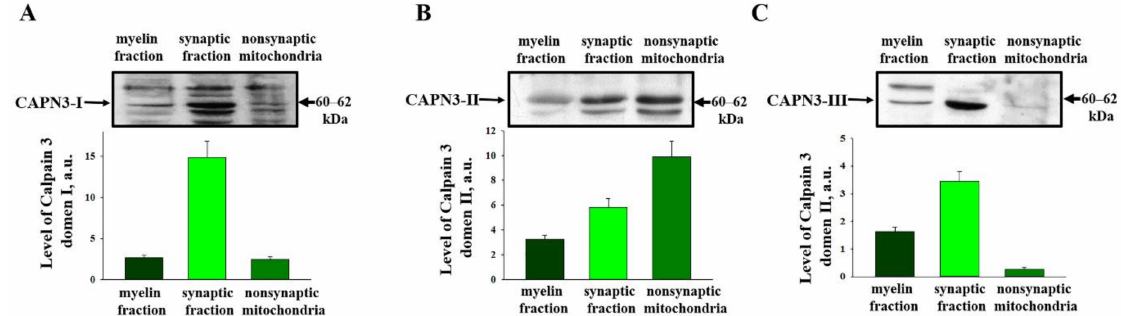
Figure 3. Distribution of Calpain 3 by fractions obtained after separation of brain mitochondria on the Percoll gradient (described in the Materials and Methods Section). ( A – C ) represent three different catalytic domains of CAPN3 ( I , II and III , respectively). The upper parts represent Western blots stained with the corresponding antibodies. The lower parts present the quantitation of immunostaining using computer-assisted densitometry. The values shown are the means ± SD from three independent